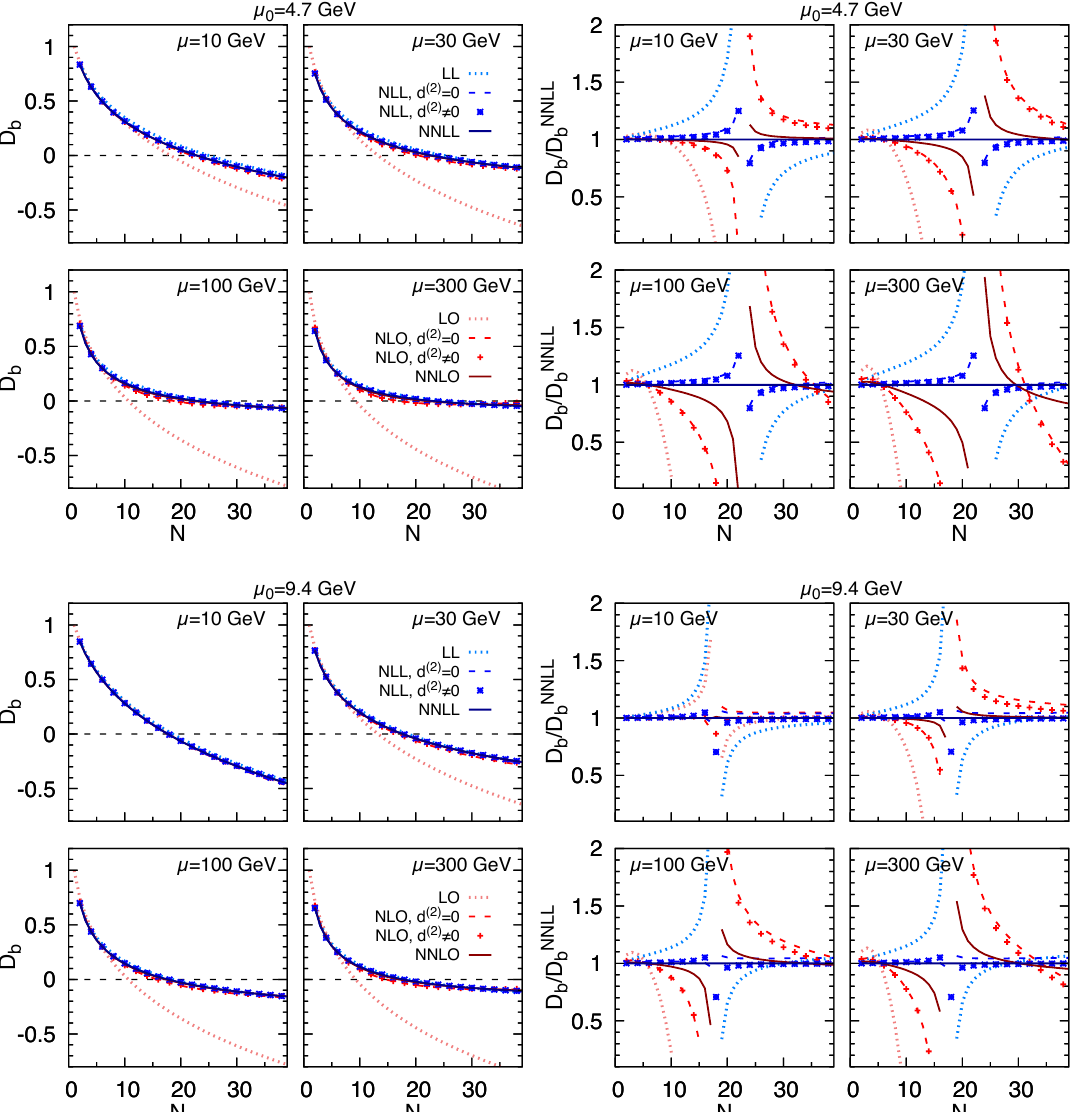
Figure 1 . The N -space bottom-quark fragmentation function, computed at di(cid:11)erent orders for the truncated solutions (LO, NLO, NNLO) and resummed solutions (LL, NLL, NNLL). NLO and NLL solutions are shown both including (symbols) and discarding (lines) the O ( (cid:11) 2 in the initial conditions. Four values of the factorisation scale (cid:22) are considered in each panel: (cid:22) = 10 ; 30 ; 100 ; 300 GeV. In the top (bottom) panels, the initial scale is set to (cid:22) 0 = m = 4 : 7 GeV ( (cid:22) 0 = 9 : 4 GeV). The right panels show the ratio over the NNLL-accurate